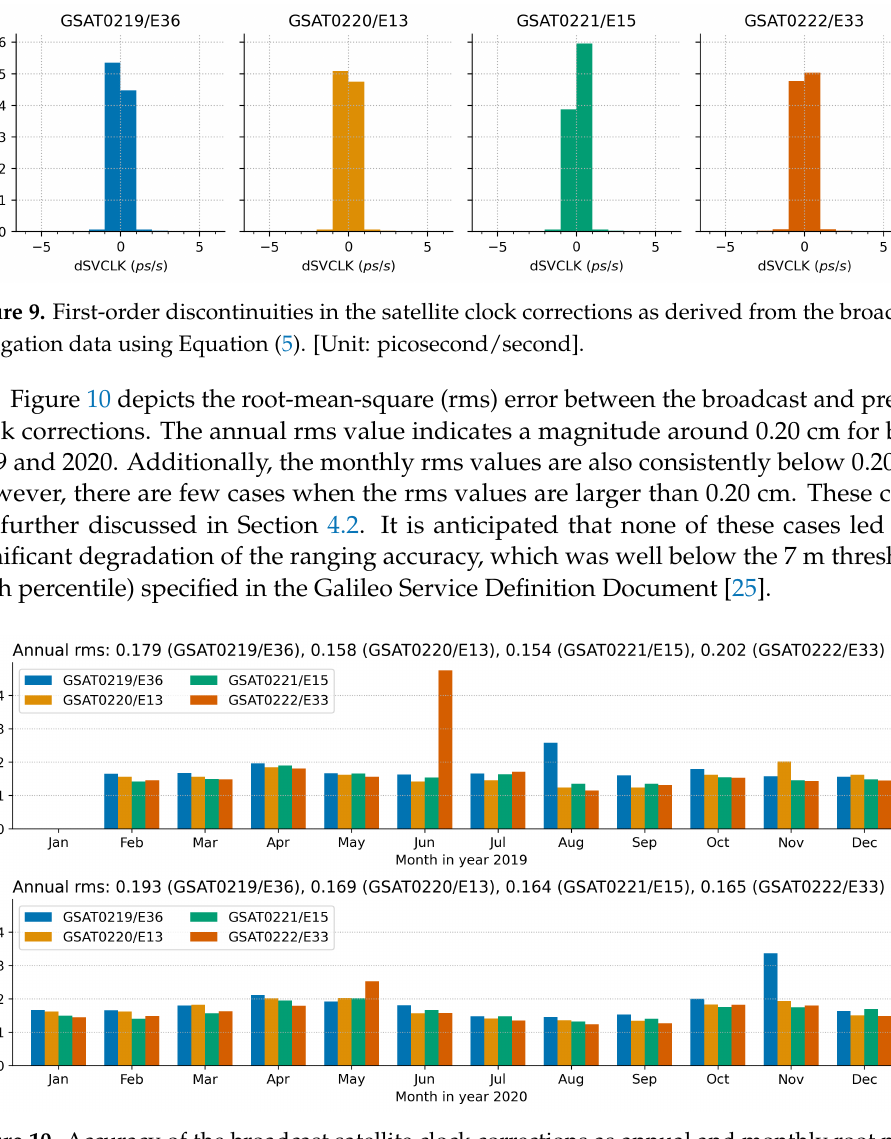
Figure 10. Accuracy of the broadcast satellite clock corrections as annual and monthly root mean square error (RMSE). The top plot displays the accuracy for year 2019, whereas the bottom plot displays the accuracy for year 2020. RMSE is computed with respect to CODE precise clock product. In addition, a constellation bias at each epoch is removed from the difference. Refer to Section 4.2 for further discussion on the results. [Unit: